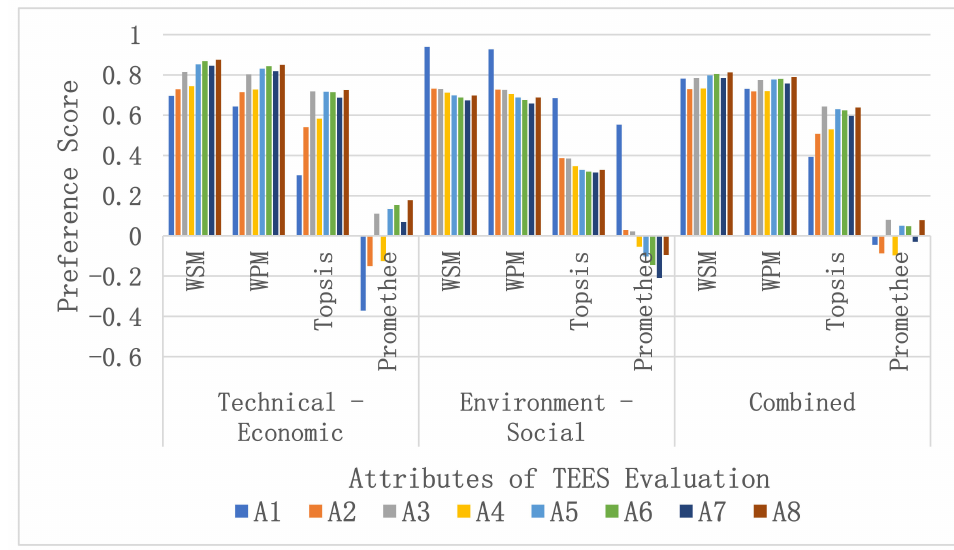
Figure 14. Attributes of TEES evaluation for C2/S2 for REG+D-STATCOM equal to the capacity of DGs only at 0.90 LPF in the 33-bus MDN under